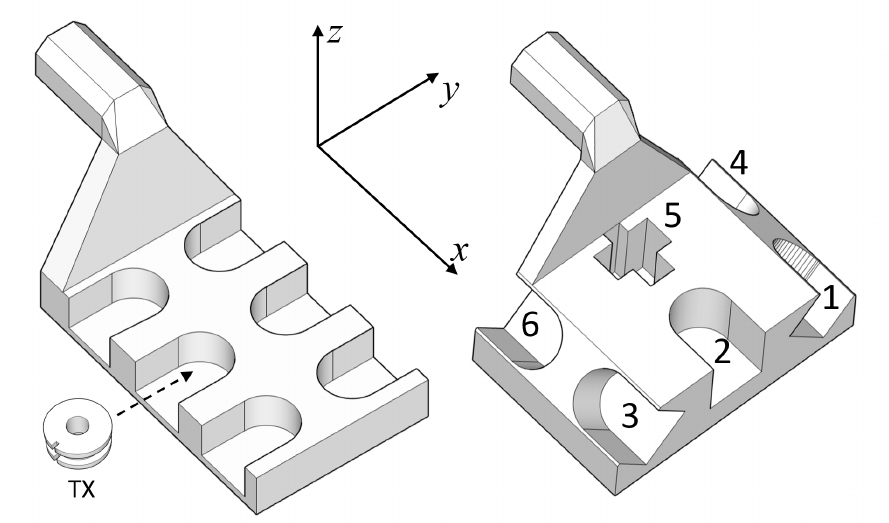
Figure 11. TX node supports for calibration ( left ) and measurement ( right ): the robot reference frame is reported. In this reference frame, the attitudes of the second support, using direction cosines notation, are ˆn 1 = ˆn 4 =